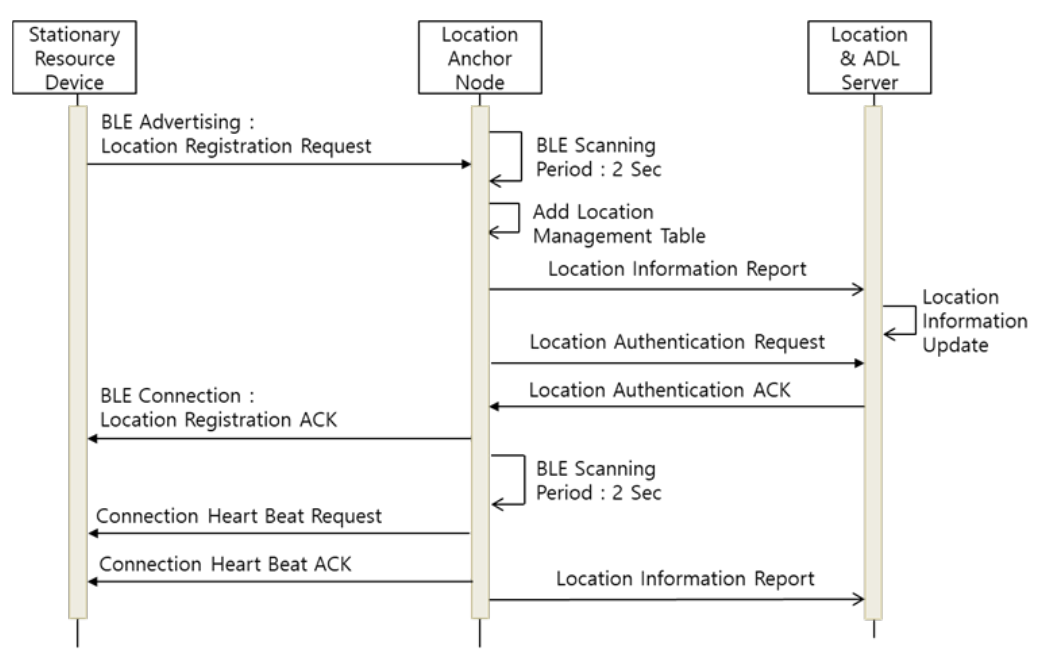
Figure 6. Cell Management and Location Registration Protocol.